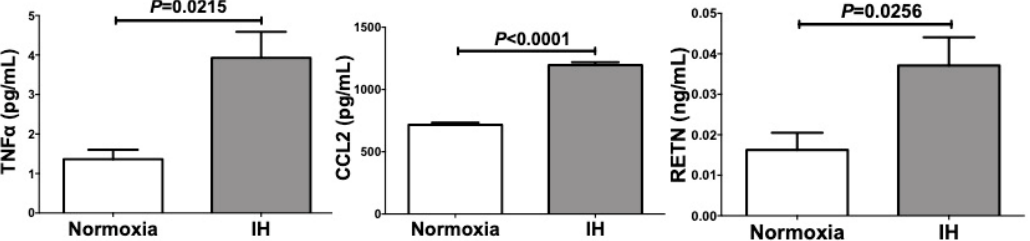
Figure 4. Concentrations of RETN, TNF α , and CCL2 in SW872 cell culture medium were measured by ELISA. SW872 cells were treated by normoxia or IH for 24 h. Data are expressed as means ± SE for each group ( n = 3).